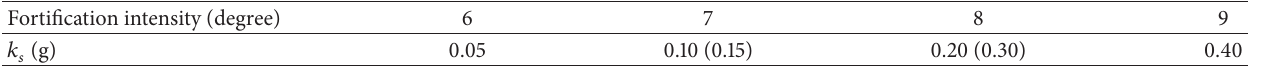
Figure 1: Distribution and calculation diagram of seismic load in subway station structure. Table 1: Earthquake acceleration basic value ( 𝑘 𝑠